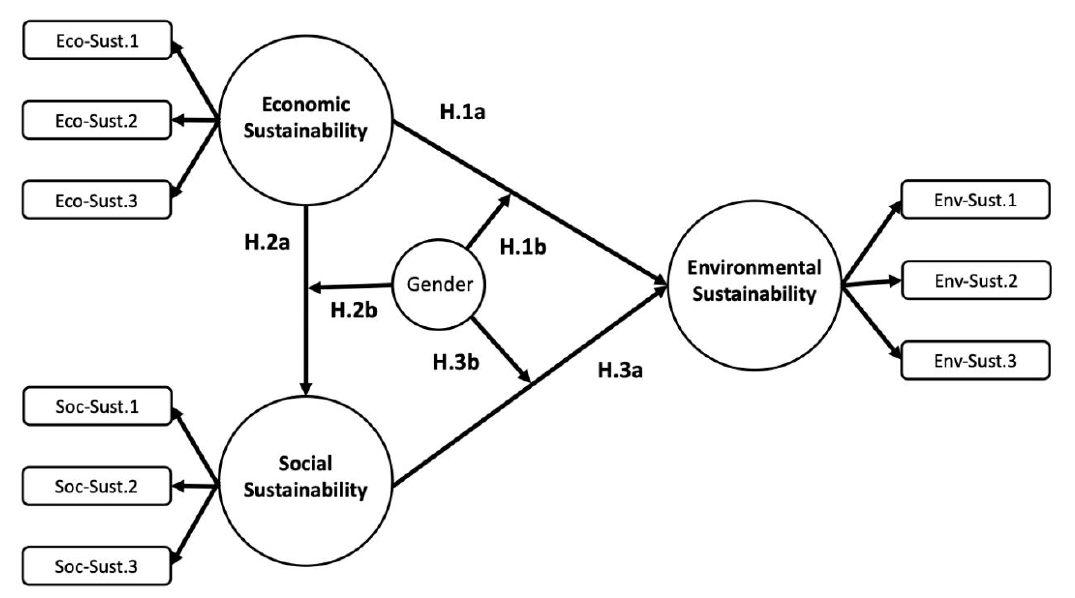
Figure 1. Proposed Research Model.